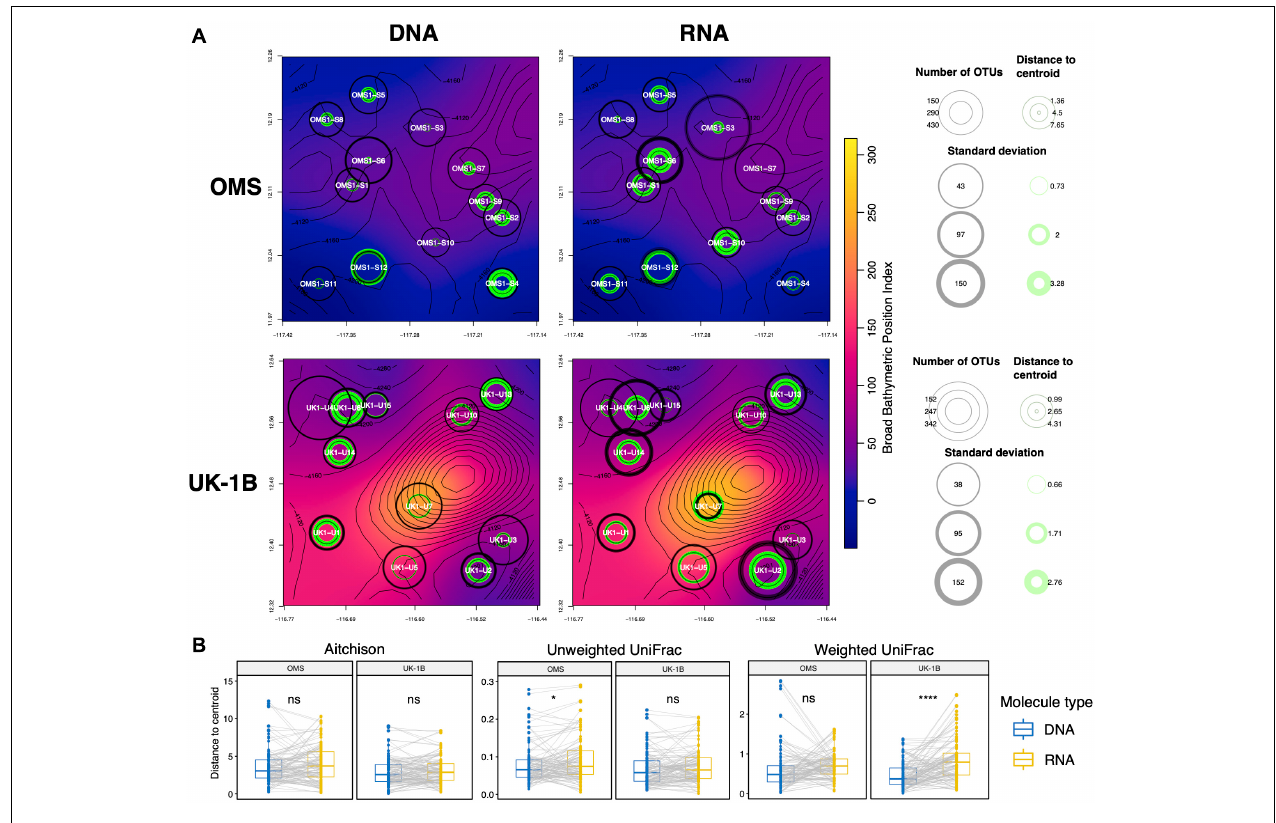
FIGURE 8 | Spatial heterogeneity expressed in terms of station beta diversity dispersion in relation to bathymetry for the 37F dataset. (A) At each station of the UK-1B and OMS strata (CCZ), we computed the distance separating the samples to the station centroid they form in the RPCA spaces obtained separately for DNA and RNA. Average and standard deviations for these distances-to-centroids are shown at each station (max. six samples per station) of each map panel (green rings), as well as for the number of OTUs (gray rings). The background color represents the Broad Scale BPI (Bathymetric Position Index) values smoothed over the plotted area. (B) Paired t -tests comparing the distributions of distance-to-centroid values between DNA and RNA are shown for the Aitchison dissimilarity metric (also used for the Robust PCA and maps) as well as for the phylogenetic, Weighted UniFrac dissimilarity